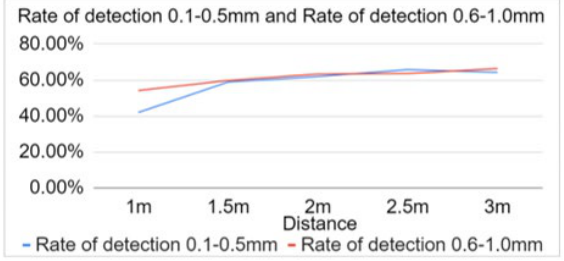
Figure 10. The chart for the rate of